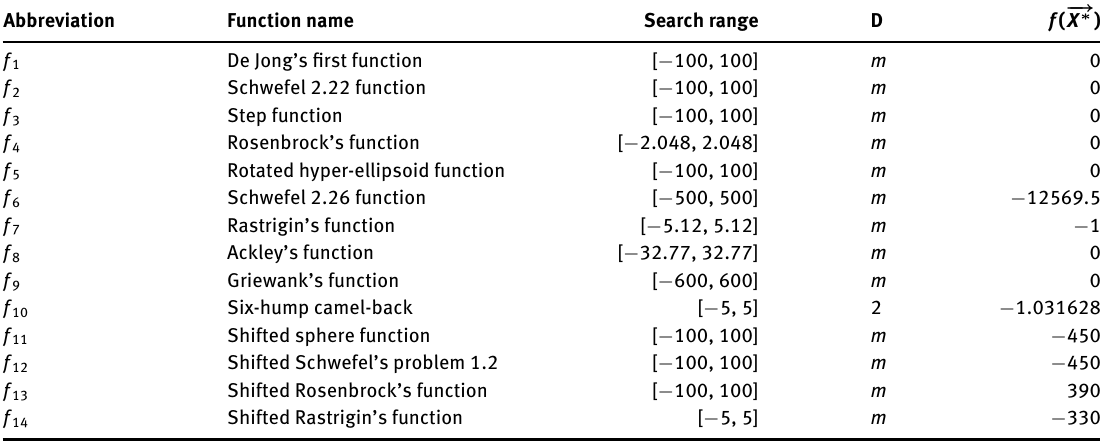
Table 1: Selected Benchmark Functions [4, 7,